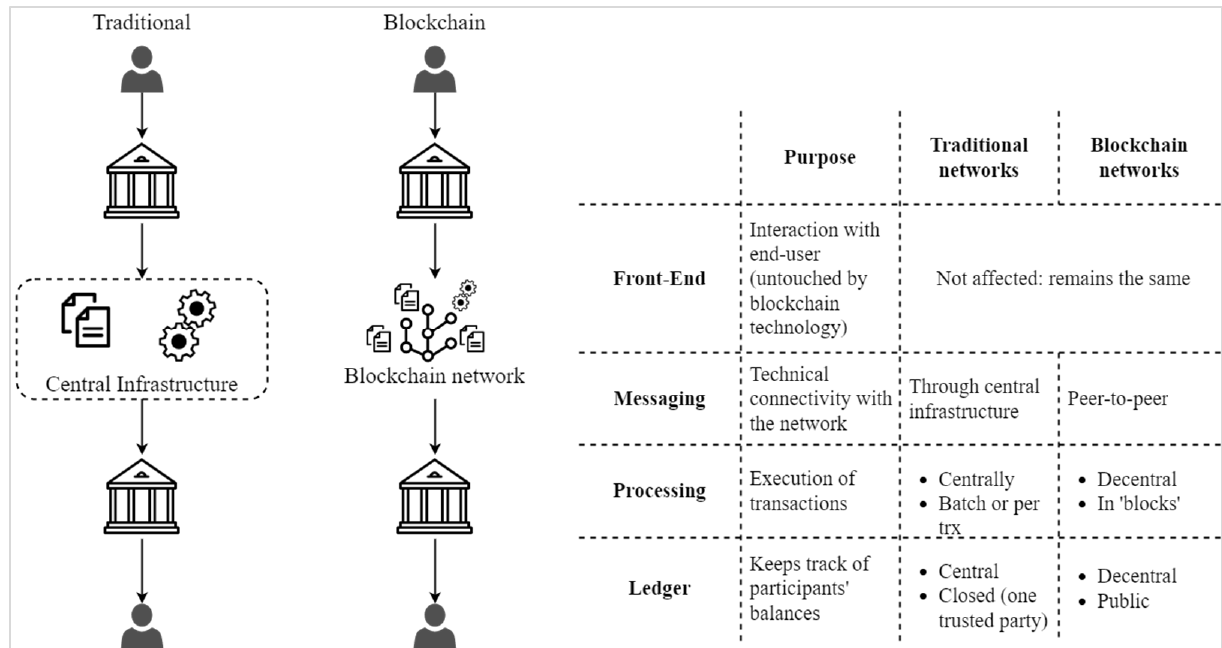
Figure 2. The transparency network comparison between traditional and blockchain.